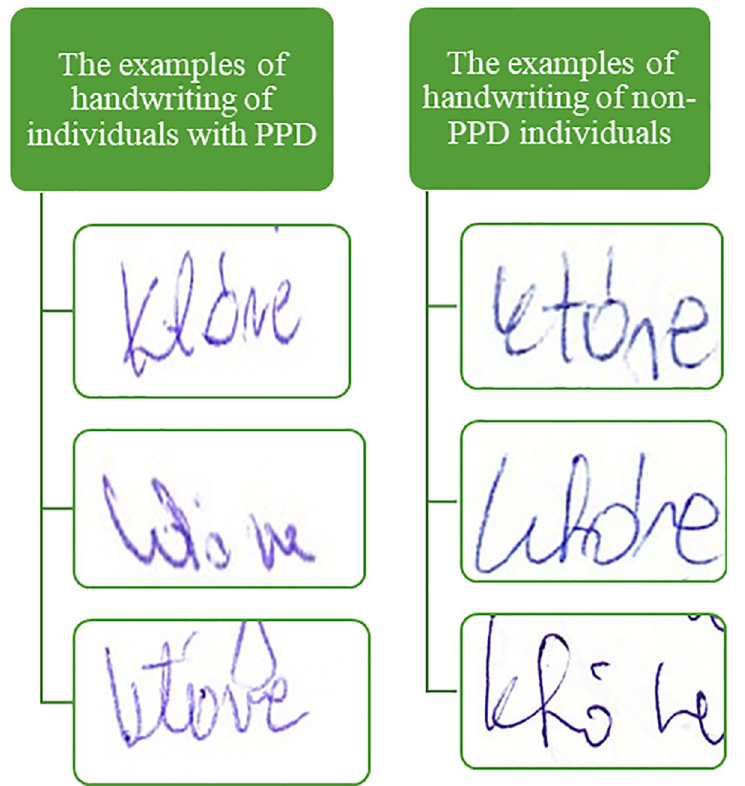
Fig 4. The examples of the analysed handwriting